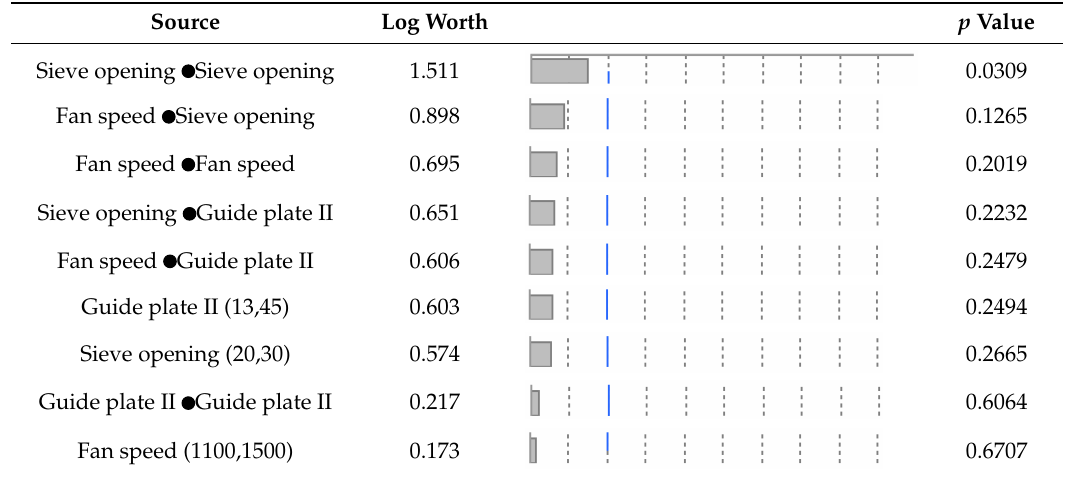
Table 5. Surface response experiment results analysis for grain impurity